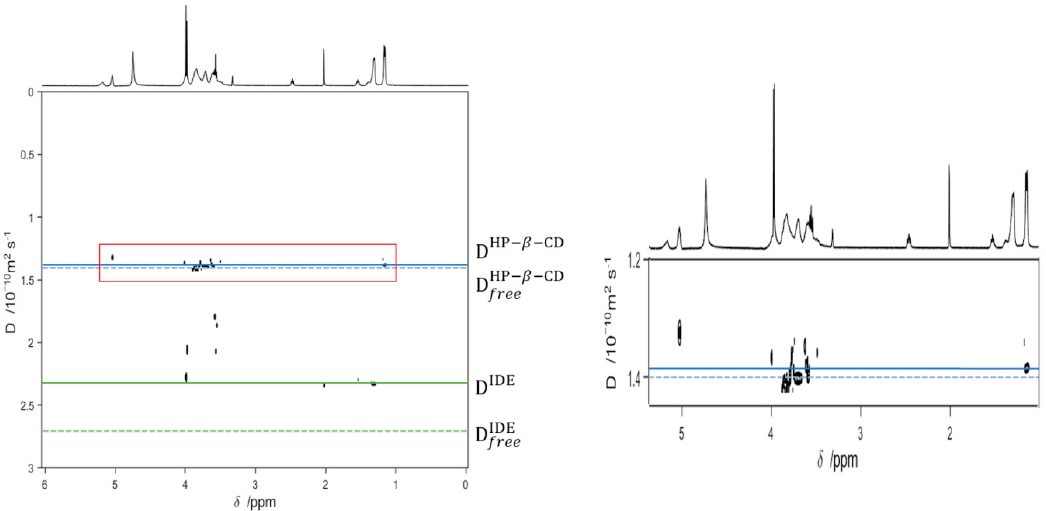
Figure 14. On the left: 2D diffusion ordered spectroscopy (DOSY)-NMR measurements on the 14 mM aqueous methanol solutions (D 2 O/CD 3 OD 1:1) of the IDE, HP- β -CD, and IDE/HP- β -CD inclusion complex. The horizontal axis represents the chemical shifts; the vertical axis represents the diffusion coefficients. The black spots are the resonances of the aqueous solution of the inclusion complex spread in the second dimension according to their measured diffusion coefficient. On the right: enlarged representation of the red box.